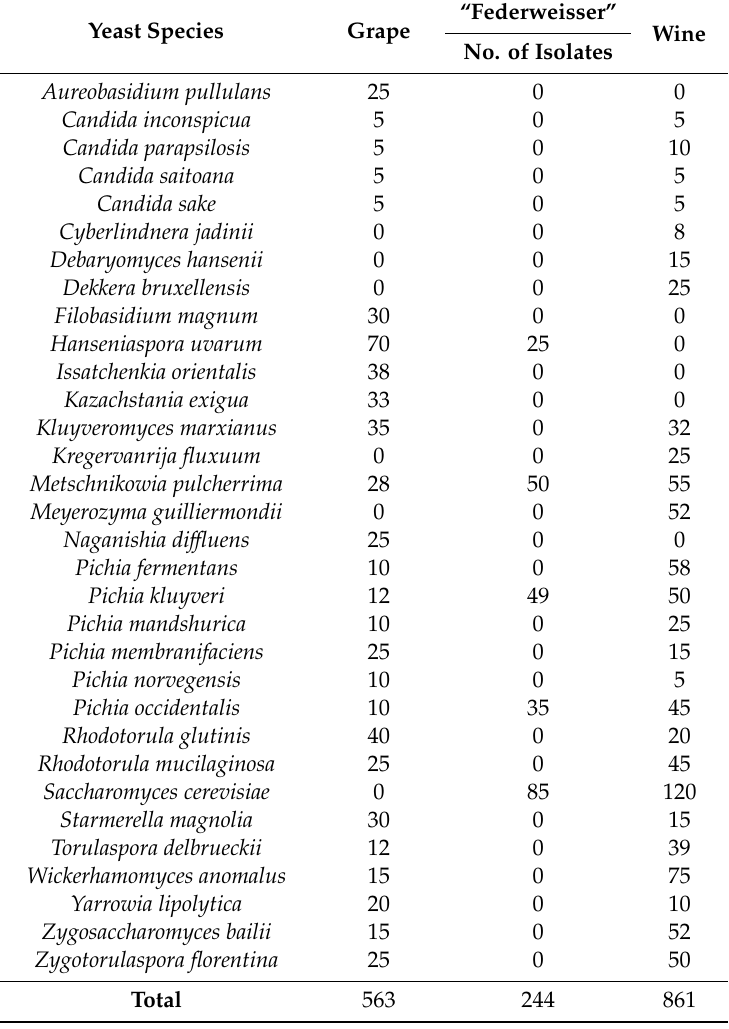
Table 10. Yeasts species in grape, “federweisser” and wine. Yeast Species Grape